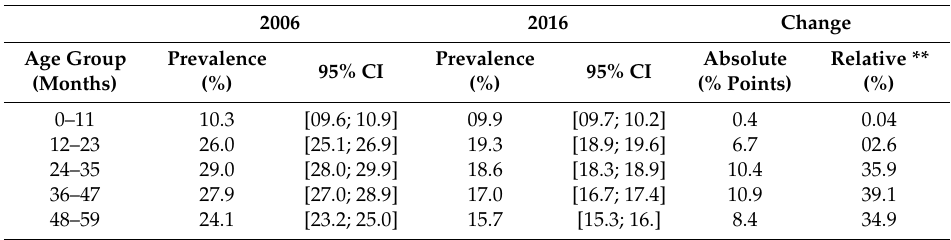
Table A1. Prevalence of severe stunting among children (below five years) by age groups, India, NFHS 2006 and 2016.